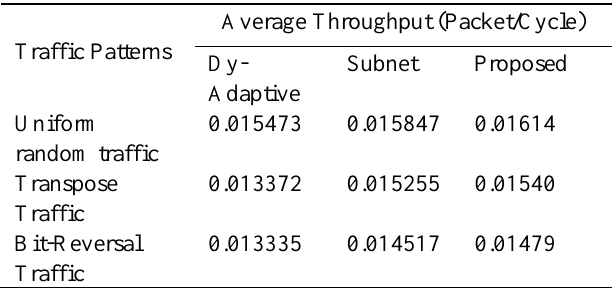
Fig. 17. Power consumption evaluation under Transpose traffic pattern